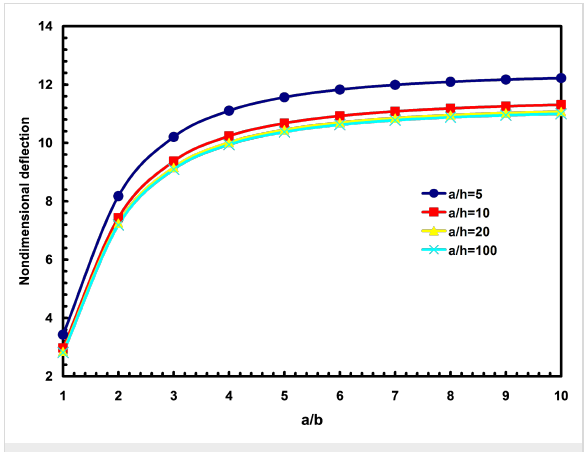
Figure 8 depicts the influences of both aspect ratio and length to thickness ratio on the nondimensional deflections under sinu- soidal loading. It can be seen that with the increase of length to thickness ratio, the deflections will decrease. It is also shown that increasing the aspect ratio will increase the deflections. It is mentioned that the nondimensional deflections for nanoplate under sinusoidal loading are less than those for nanoplates subjected to uniform load, as shown in Figure 1 and Figure 8.